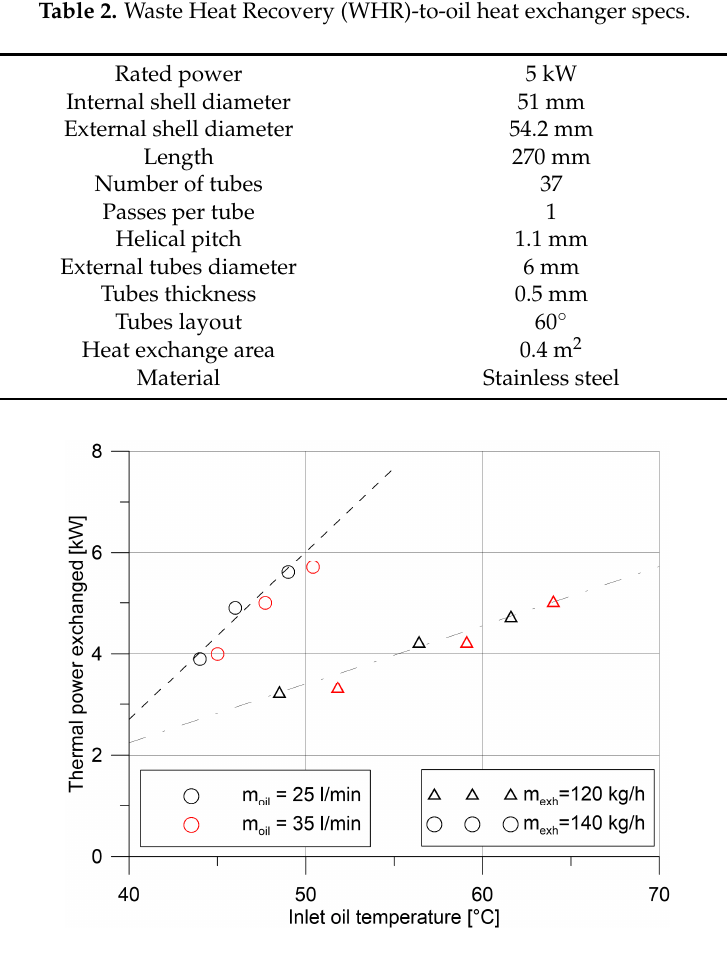
Figure 6. Experimental arrangement of the heat exchanger in the external oil circuit on the engine test bench. 3. WHR-to-Oil Heat Exchanger Experiment The WHR-to-oil heat exchanger has been placed in the exhaust line, as in Figure 1 , and the F1C engine has been run to reproduce the torque-speed working point of a NEDC homologation cycle. The WHR section is active only during the cold phase. In fact, until the temperature of the oil in the sump reaches a suitable hot temperature of 80 °C, the WHR-to-oil heat exchanger is crossed by the exhaust gases on tubes side and lubricant oil on the shell side. After the reaching of this suitable temperature, the WHR-to-oil heat exchanger has been bypassed in the exhaust line and, in the lubricant circuit, the coolant-to-oil heat exchanger branch is opened, excluding the WHR ( Figure 1 ). In this way, the lubricant oil can be thermal-regulated by the coolant and, on the exhaust side, backpressure effect is reduced and reported to the original configuration. The WHR-to-oil